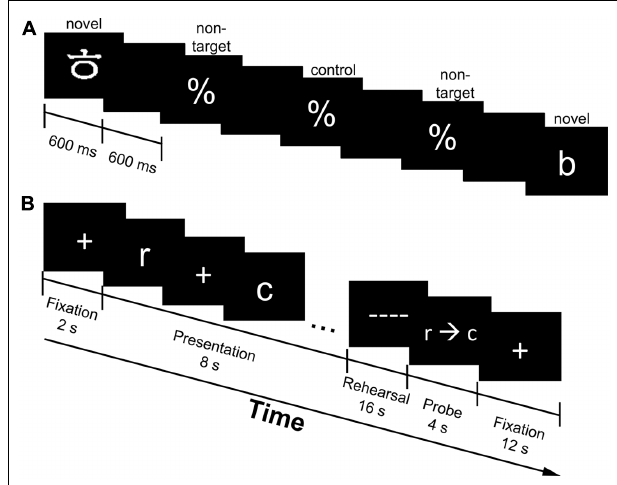
FIGURE 1 | Experimental design of the oddball (A) and working memory [WM; (B)] task. The oddball task consisted of novel targets (Korean and English letters), non-targets (percentage signs) and control targets (same as non-targets, but used as the baseline condition for comparison purposes; one-third of the time the percentage signs were denoted as the control targets); stimulus duration was 600 ms, while the interstimulus interval was 600 ms. (A) . Presented is an example sequence of a novel target (Korean letter) followed by a series of standard stimuli (%) and another novel target (English letter). Participants indicated whenever they saw a stimulus that was not a percentage sign.TheWM task consisted of verbal (English letters only) and object (Korean letters only) trials. Presented is a verbal trial followed by a correctly ordered probe (B) . A fixation cross marked the onset of each trial (2 s), followed by the presentation of five randomly selected stimuli (all verbal or all object; 8 s). Participants were to rehearse the stimuli in serial order (16 s) and make a response when the probe (r → c) was presented (4 s). A fixation cross marked the end of the trial (12